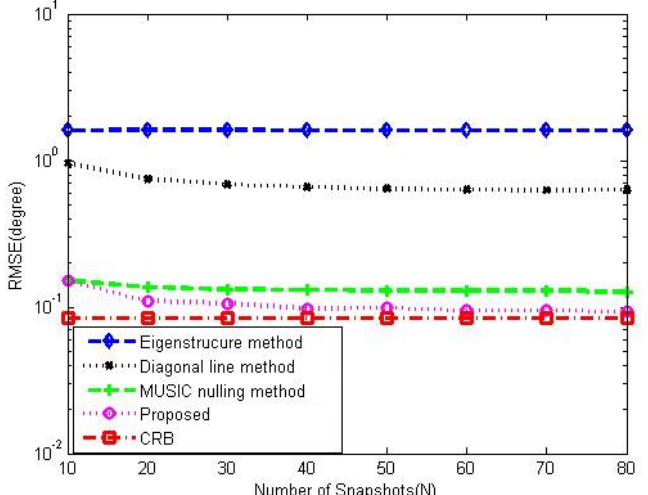
Figure 15. DOA performance comparison among the corresponding gain-phase estimation methods versus number of snapshot in 5-element ULA with deterministic gain-phase errors, CSR = 30 dB, SNR = 20 dB, K 0 = 20, T 0 =